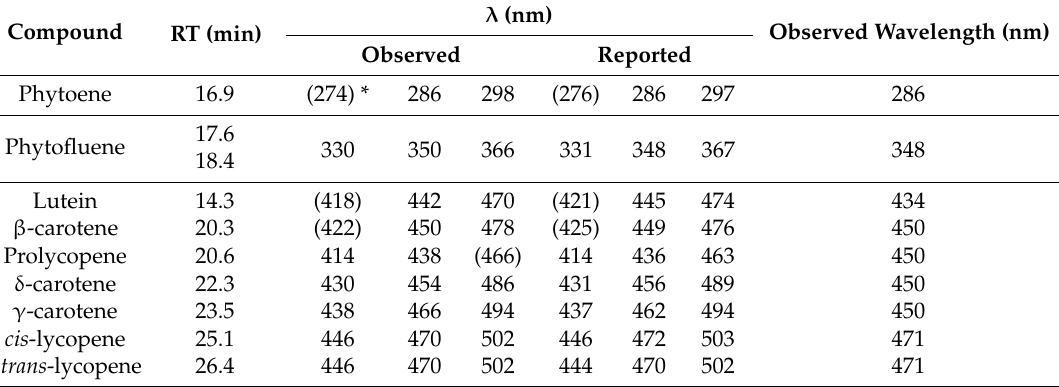
Table 1. Identification of carotenoids in tomato fruits based on the retention time and absorption maxima over the observed